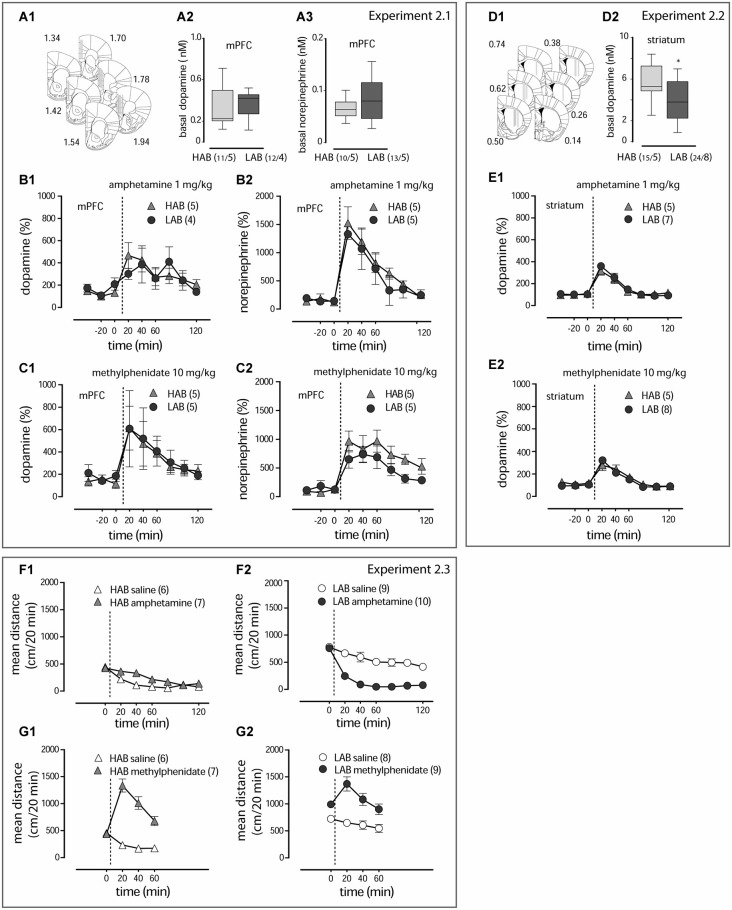
Amphetamine and methylphenidate action on dopamine and norepinephrine release (A1, D1). The schematic diagrams show placement of microdialysis probes in subsequent coronal sections of the mPFC and striatum. The computer-based atlas by Paxinos and Franklin (2001) was used to mark probe locations; numbers refer to distances from the bregma, mm. (A2,3,D2). Basal values of dopamine and norepinephrine in the mPFC and dopamine in the striatum of LAB and HAB mice. *p < 0.01; “n/N” represent the sample size/number of animals under evaluation. Amphetamine (1 mg/kg, i.p.) and methylphenidate (10 mg/kg, i.p.) evoke comparable dopamine and norepinephrine release in the mPFC (B1,2,C1,2) and striatum (E1,2) of both LAB (circles) and HAB (triangles) mice. Amphetamine (1 mg/kg, i.p.) decreases hyperactivity in LAB mice (circles in contrast to the stimulatory effect in HAB mice (triangles) (F1,2). Methylphenidate (10 mg/kg, i.p.) stimulates locomotion in both lines (G1,2). The dashed lines define the moment of drug administration.